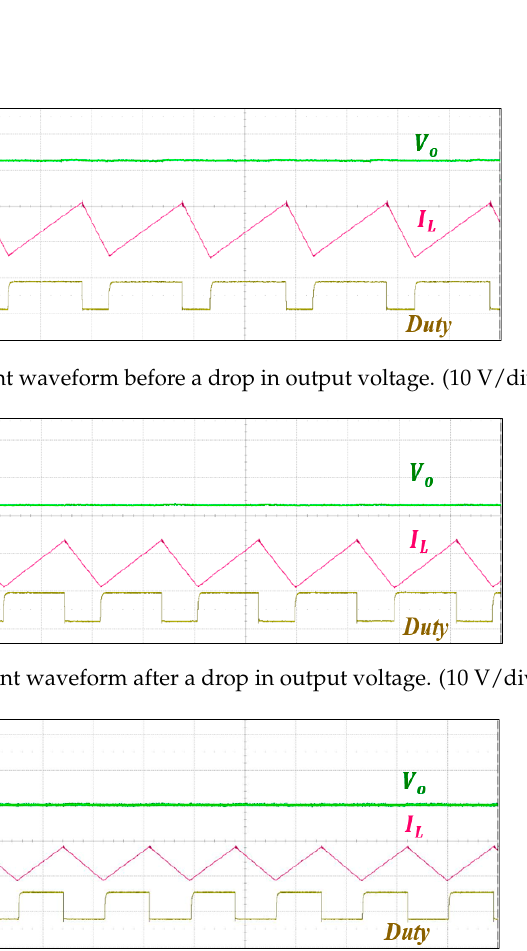
Figure 24. Inductor current waveform when the output voltage is raised in the proposed hybrid